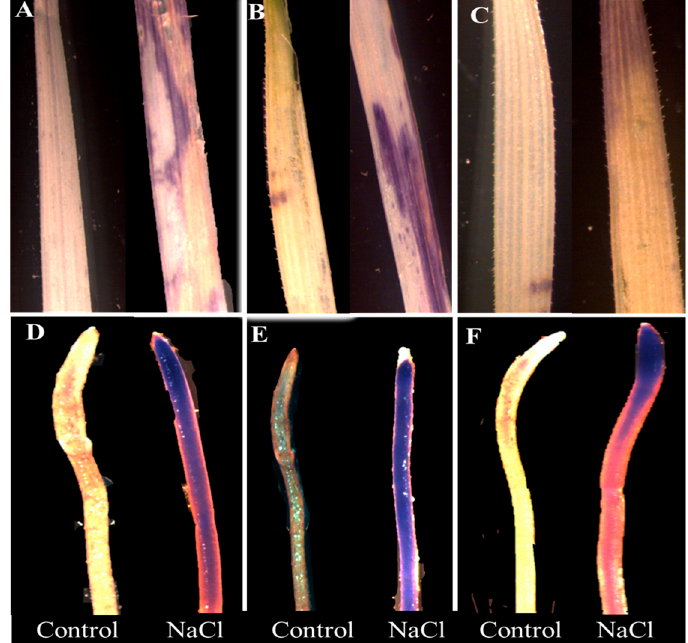
Figure 2. Histochemical detection of H 2 O 2 by NBT (nitro-blue tetrazolium) staining in leaves (top row) and roots (bottom row) of two wheat cultivars—Suntop ( A, D ), Sunmate ( B, E )—and barley cultivar CM72 ( C, F ). The samples were collected after 7 days of 100 mM NaCl treatment.